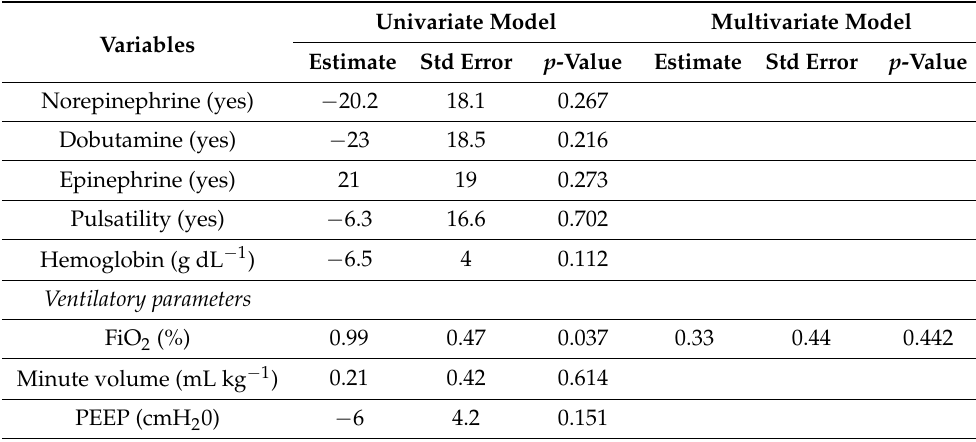
Table 2. Mixed generalized linear model with random “subject” for longitudinal analysis of the variables associated with right radial artery PaO 2 . A univariate analysis was followed by a multivari- ate